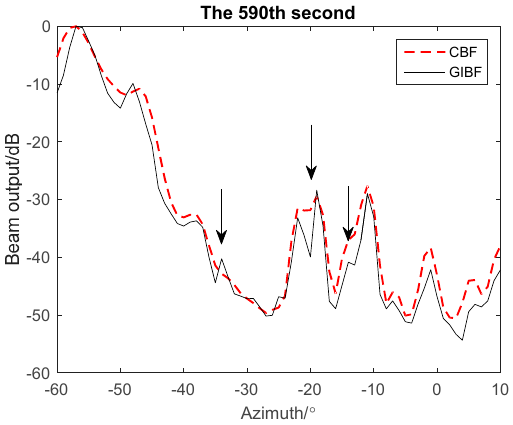
Figure 8. Results of GIBF and CBF processing in 590th seconds of experimental data.